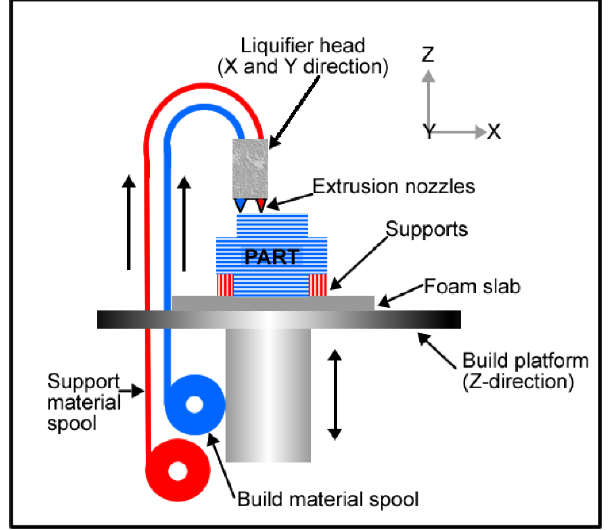
Figure 4. Material extrusion process schematic [22]; published under MDPI open-access license.